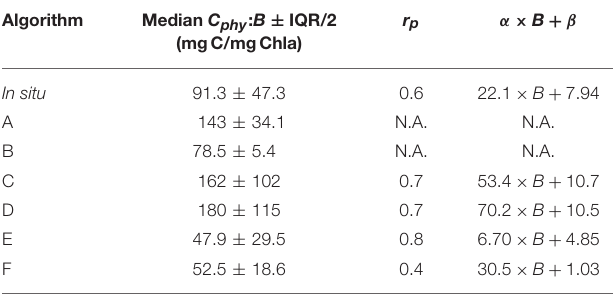
TABLE 4 | Summary of statistics for the C phy to B relationships.